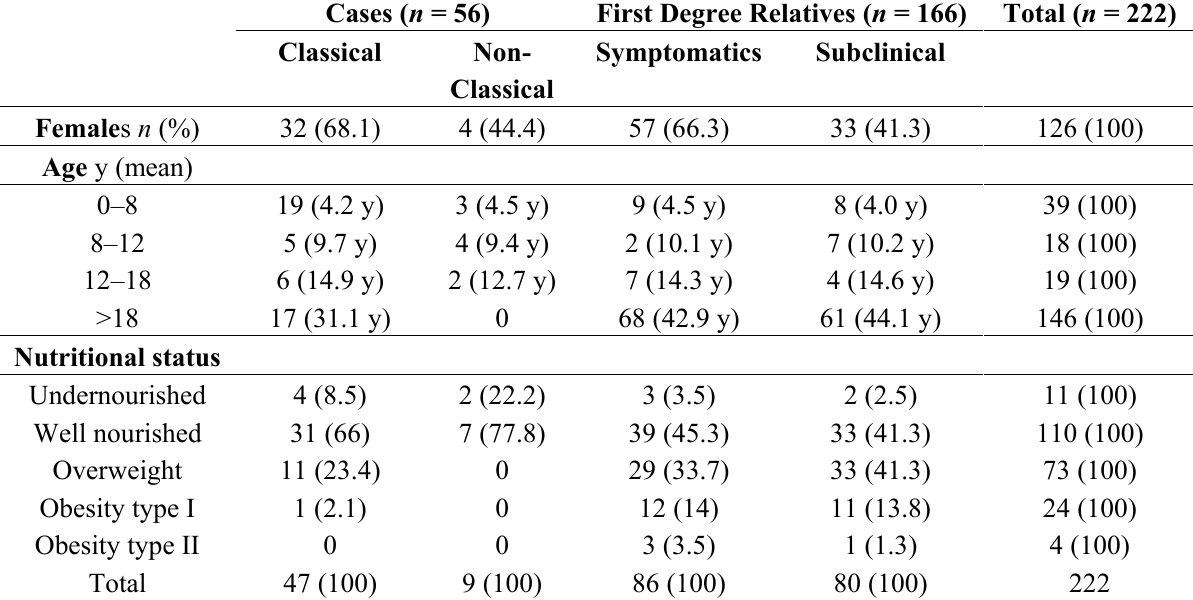
Table 1. Sex, age and nutritional status in celiac cases and their first degree